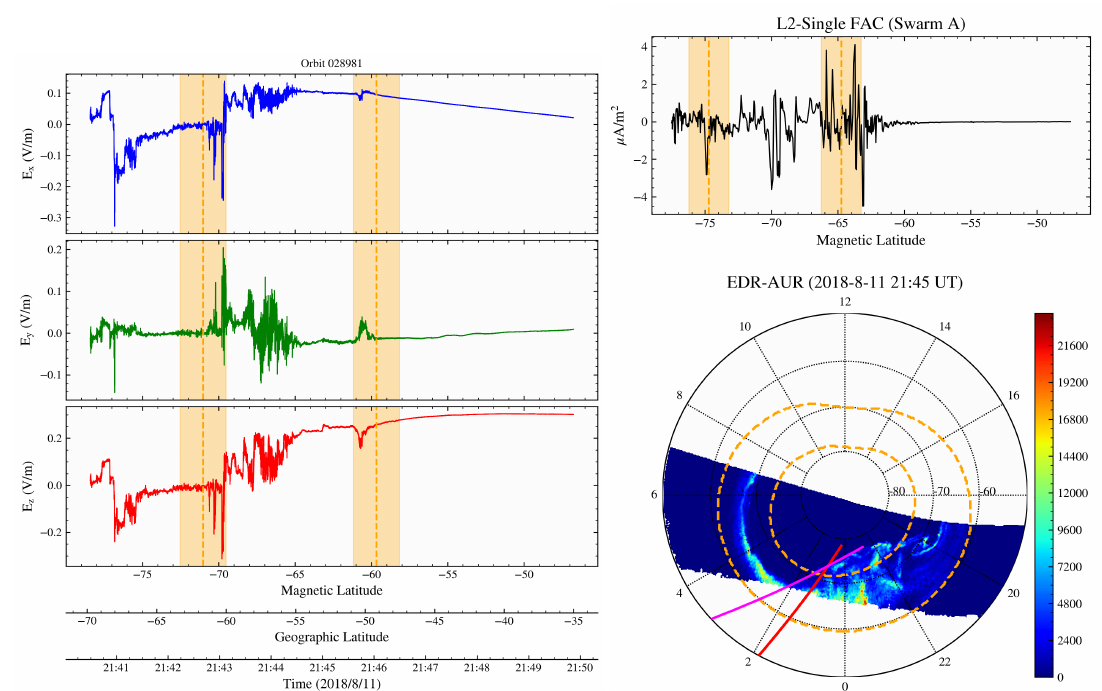
Figure 1. ( Left ): Electric field measurements collected by CSES-01/EFD on 11 August 2018 from 21:40:29 UT to 21:49:52 UT. The three components are in the spherical coordinates of the WGS84 reference frame. ( Top right ): L2-Single FAC product as calculated from Swarm A observations [23] taken on 11 August 2018 from 22:20:10 UT to 22:30:42 UT. ( Bottom right ): coloured contour of the auroral emission as measured in the LBHL band by the SSUSI instrument on board DMSP-F17 in the geomagnetic AACGM (Lat, MLT) reference frame. The orange dashed curves denote the modeled boundaries of the AO, the red curve is the orbital trajectory of CSES-01, and the magenta curve is the orbital trajectory of Swarm A, while the vertical dashed orange lines and areas in the left and top right panels denote the latitudes of the AO boundary from GUVI fits, together with a fiducial error of ± 1.5 ◦